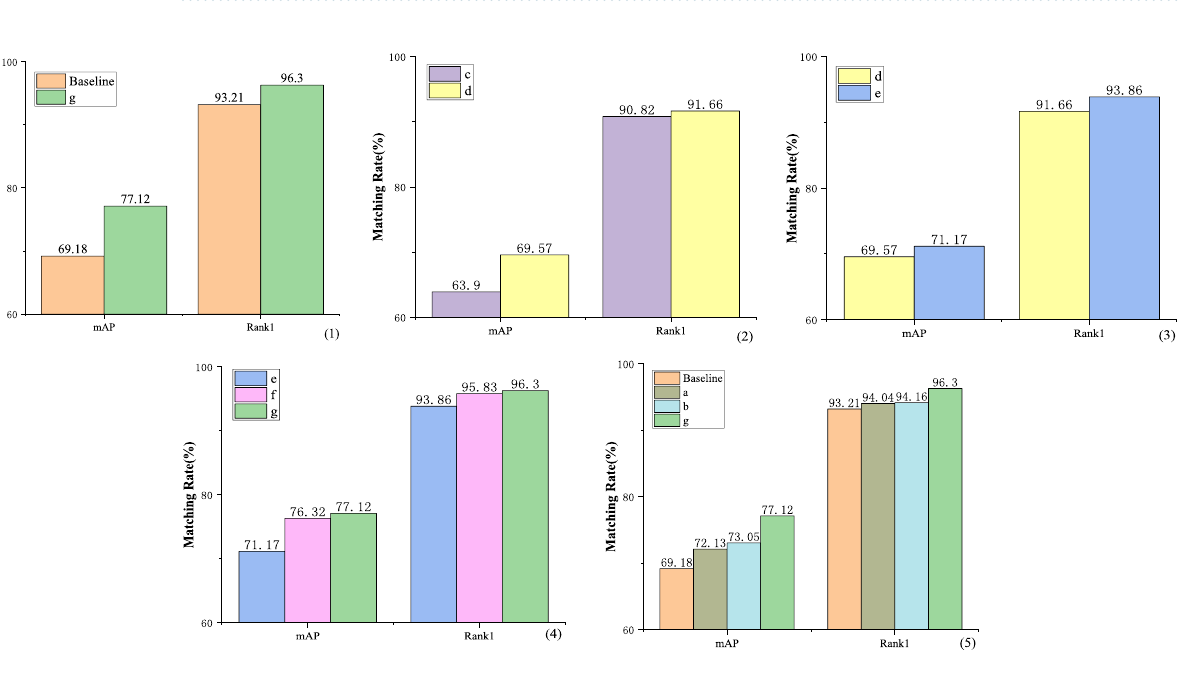
Figure 6. Ablation Experiment of the proposed framework on VeRi-776 dataset (in